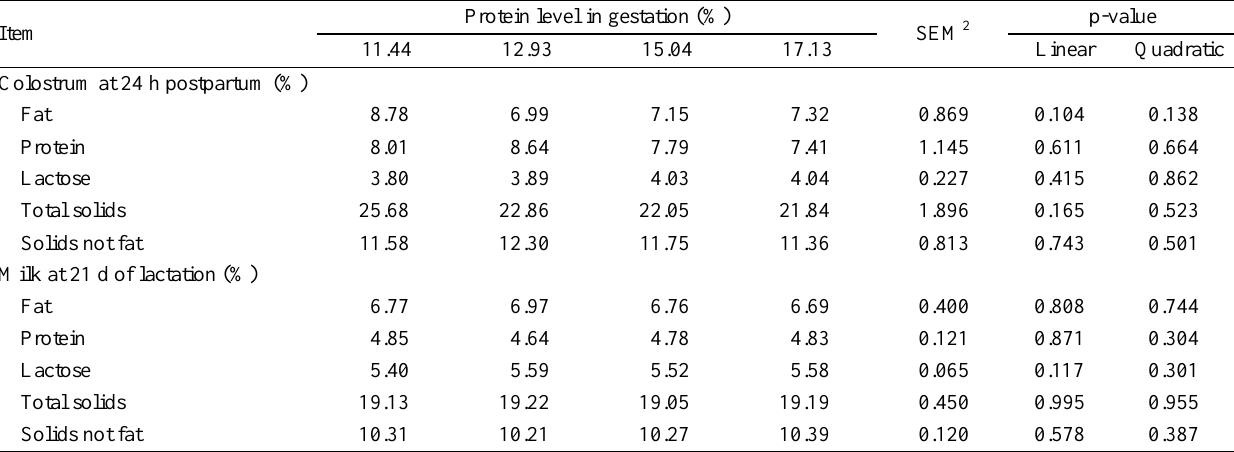
Table 6. Effect of CP levels in gestation diets on milk composition of primiparous sows